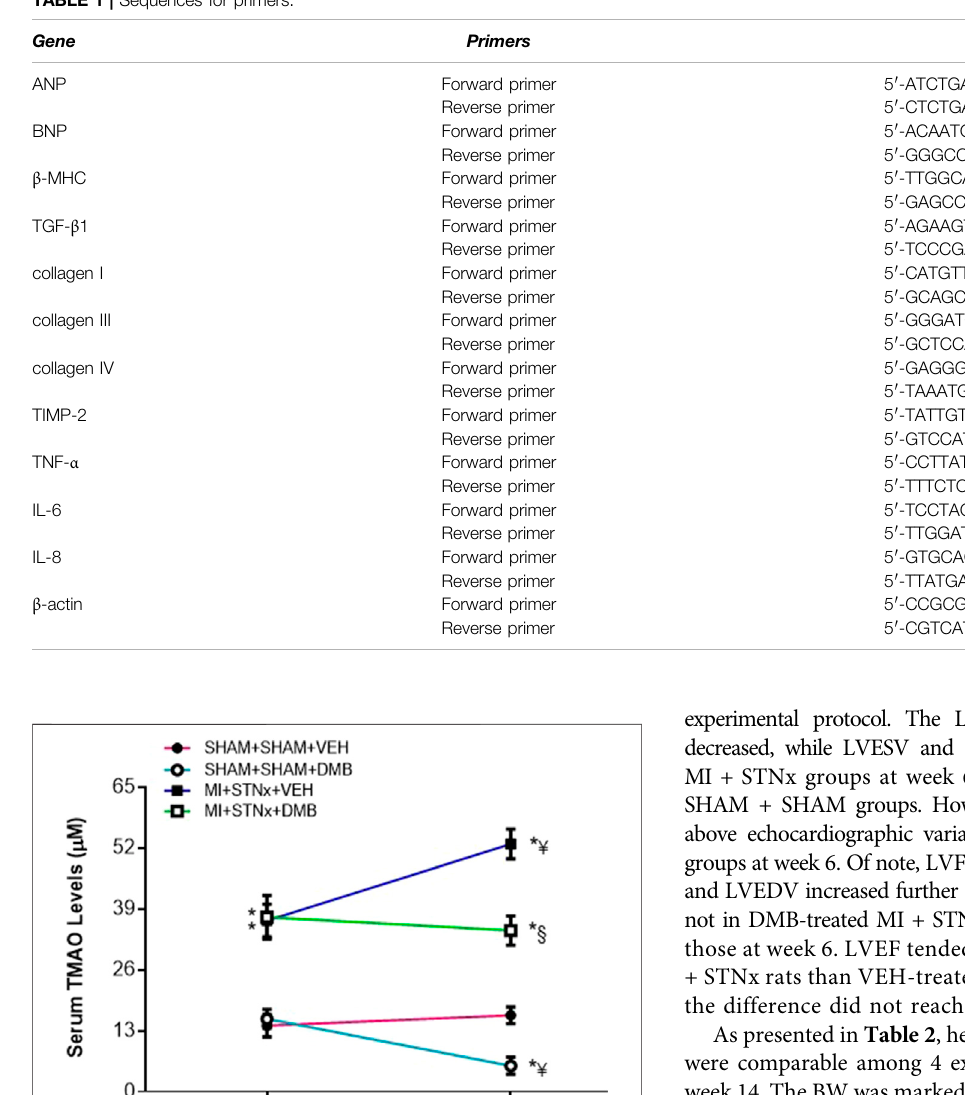
TABLE 1 | Sequences for primers.